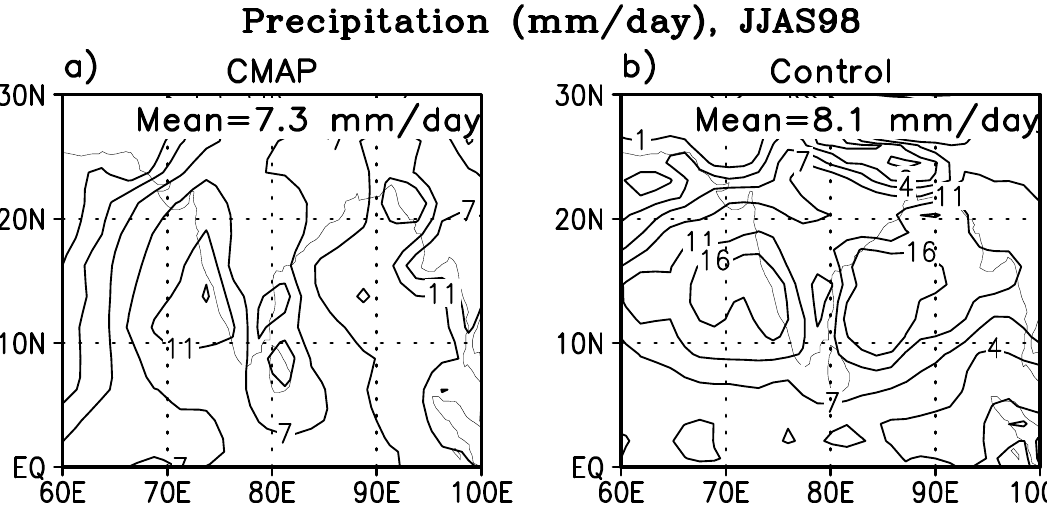
Fig. 1. Precipitation rate (in mmday − 1 ) over the South Asian monsoon region during June–September 1998 from CMAP (Xie and Arkin, 1997) and the ensemble mean of the control simulations of the NCMRWF model. Contour are drawn at 1, 2, 4, 7, 11 and 16 mmday − 1 levels. The domain averaged values are indicated at the top-right corner of the respective